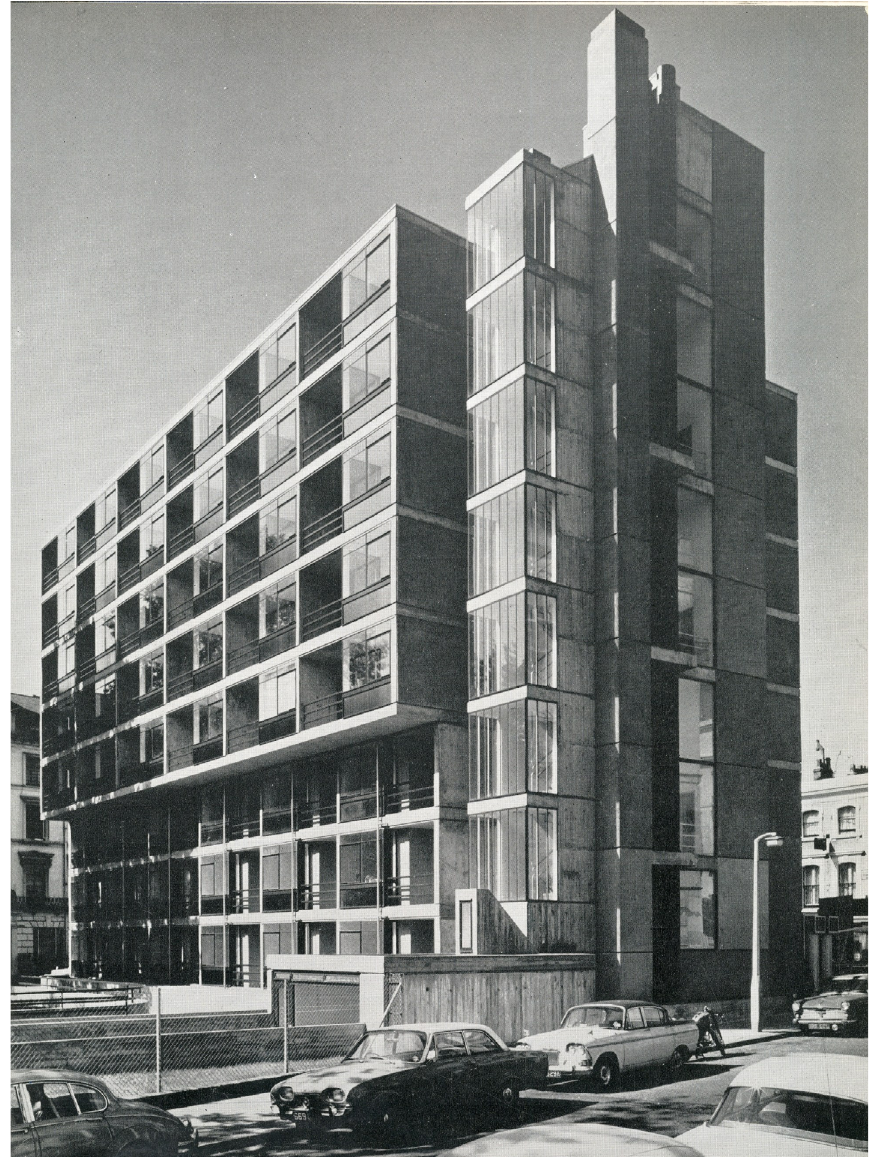
Photograph of the block of flats that Frampton worked on